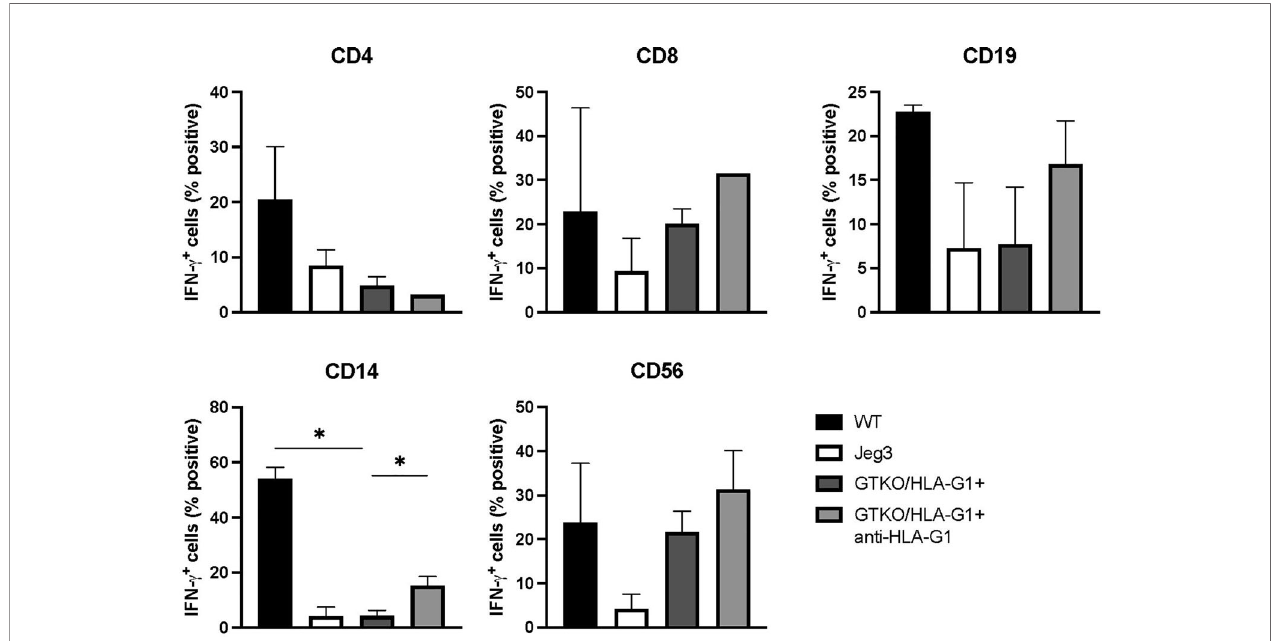
FIGURE 5 | Transgenic porcine HLA-G + cells dampen IFN- g secretion from various subsets of human PBMCs in co-culture. Proportion of CD4 + , CD8 + IFN- g + T cells; CD19 + IFN- g + subset; CD14 + IFN- g + macrophage subset; CD56 + IFN- g + NK cell subset. All cultured cells were harvested after 48h. JEG-3 cells were used as positive controls for HLA-G expression. Data shown are presented as mean ±